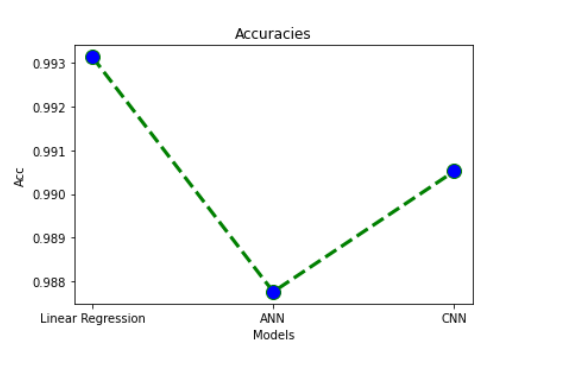
Figure 8. Comparison of Accuracies between ML Models for the prediction of Close Price